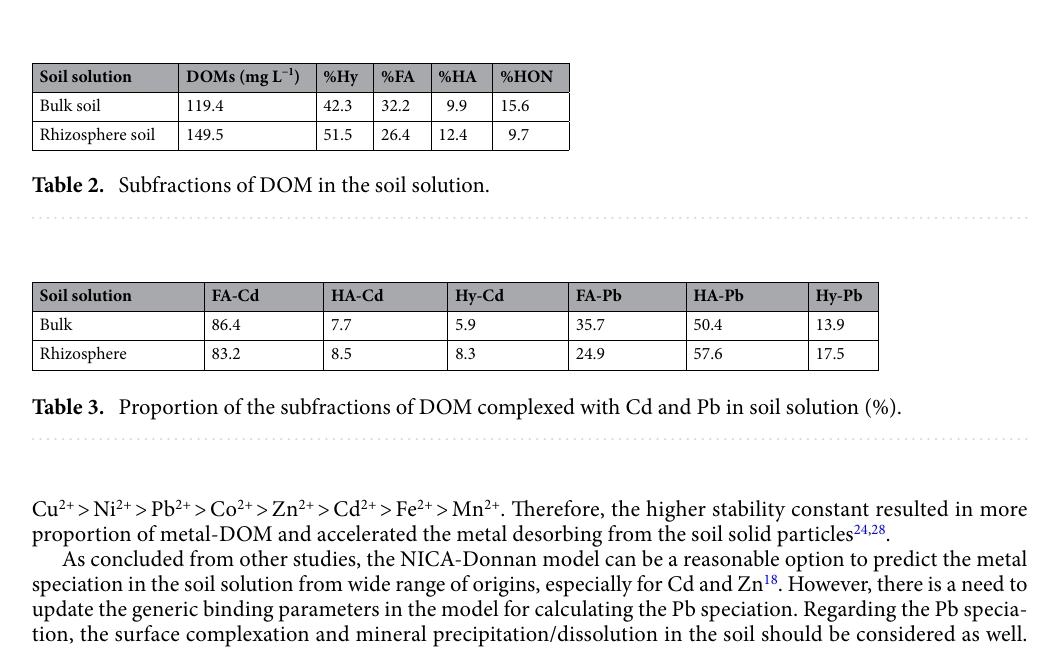
Figure 2. Proportion of Cd and Zn speciation in rhizosphere soil solution of S. alfredii.